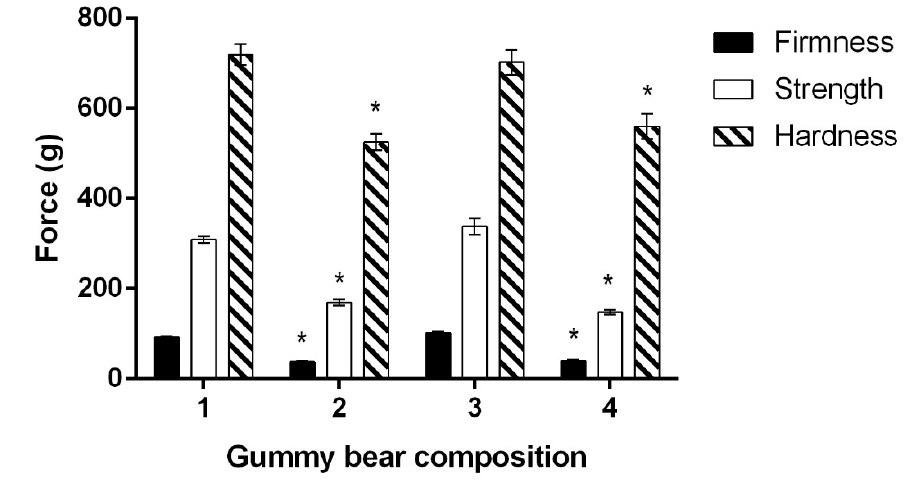
Figure 2. The influence of gummy bear composition on the textural properties. * p < 0.05 vs. 1, 3 compositions.